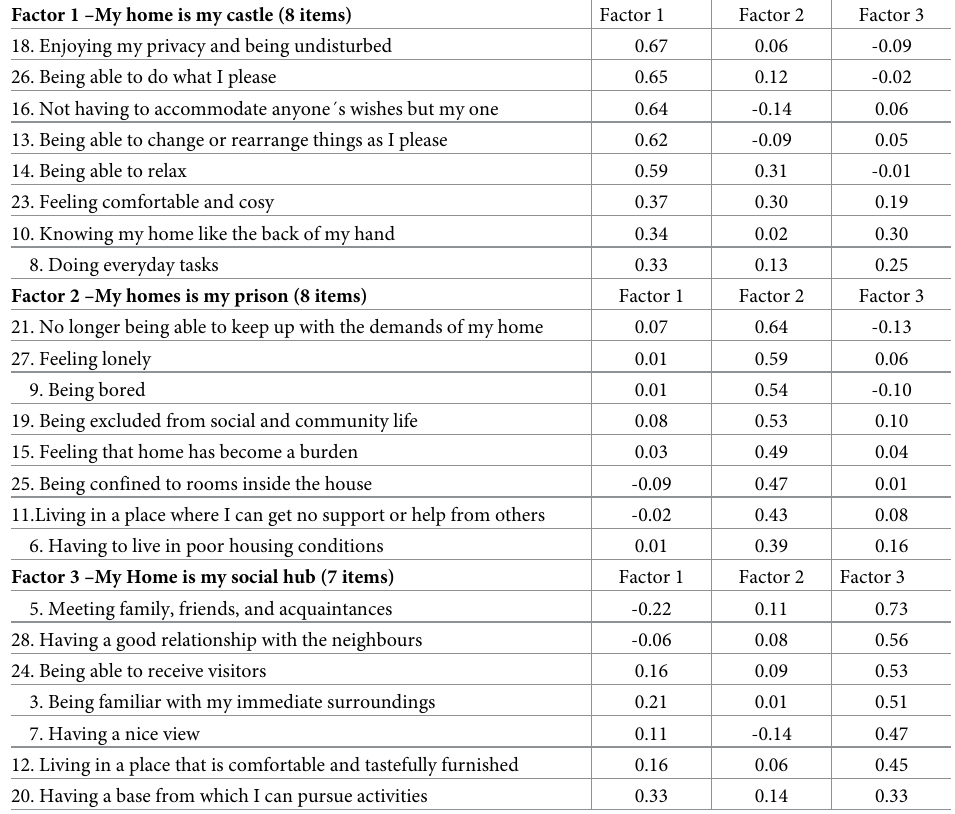
Table 2. Exploratory factor analysis with oblimin rotated factor loadings of the 23 items version MOH. Factor 1 –My home is my castle (8